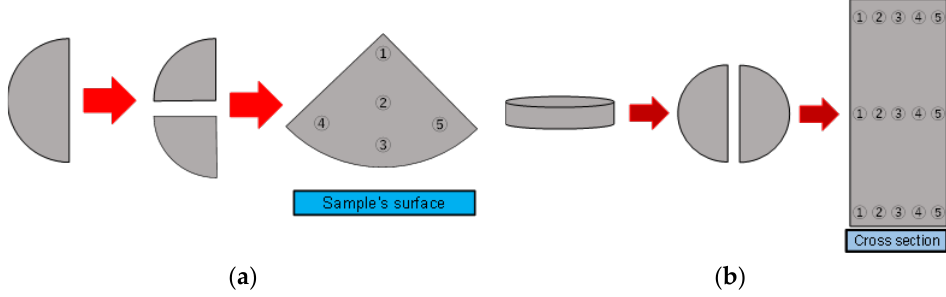
Figure 4. Micro Vickers hardness testing points on ( a ) surfaces, and ( b ) cross sections. The centrifugal force direction corresponds to 1 (cid:13) ⇒ 5 (cid:13) in ( b ).